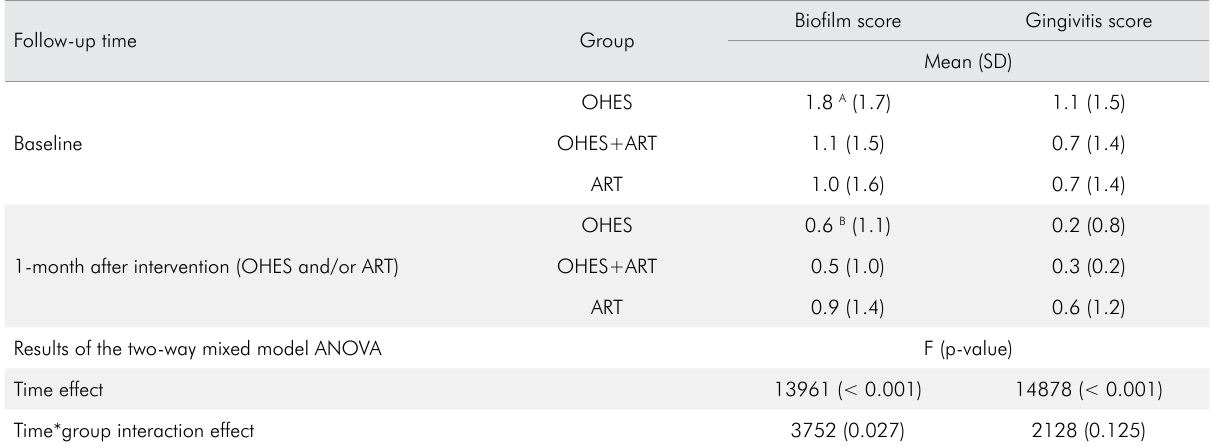
Table 4. Follow-up description of samples according to biofilm and gingivitis scores and the interaction effect time*group: a Two- way Mixed Model